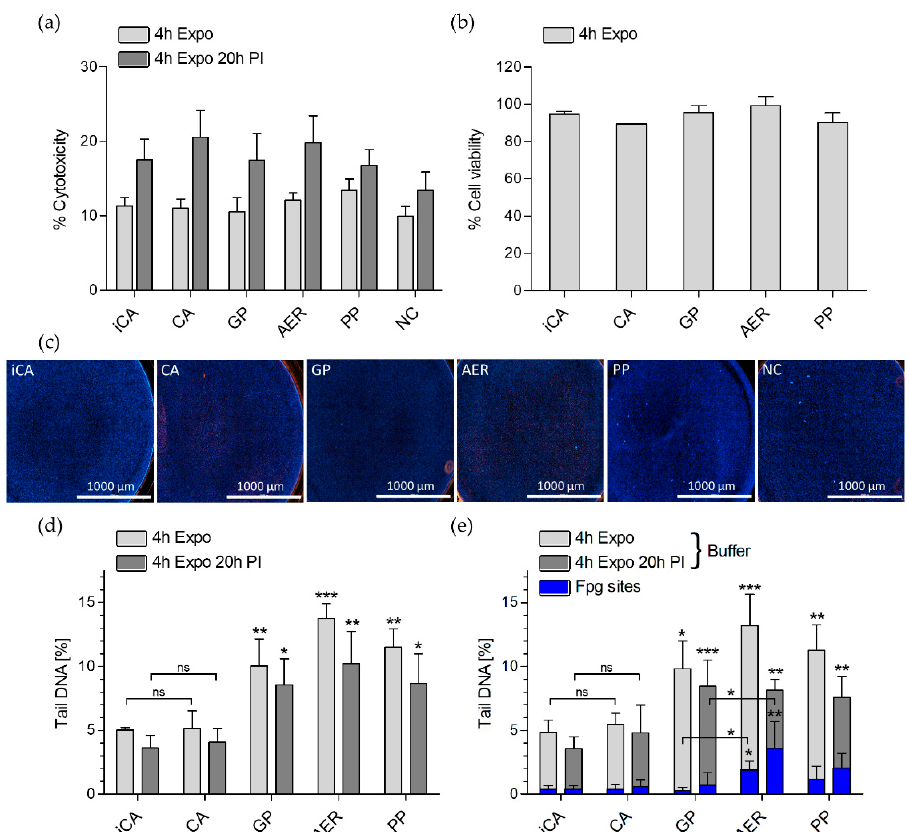
Figure 2. Toxicity assessment of DBP gas versus particle phase and total aerosol on human lung A549 cells exposed at ALI. A549 cells were exposed to DBP over 4 h with or without 20 h post incubation (4 h Expo or 4 h Expo 20 h PI). ( a ) % Cytotoxicity compared to the NC measured by LDH assay and normalized to the total LDH release (2% Triton X-100 positive control) ( n ≥ 6), ( b ) % Cell viability measured by resazurin assay and normalized to the NC ( n = 3), and ( c ) Live/dead cell imaging with 5 µ g/mL H 33342 to stain the nuclei (blue) and 2.5 µ g/mL propidium iodide (red) to selectively stain dead cells after 4h Expo to iCA, CA, or the different SVOC phases of DBP. ( d ) Genotoxicity assessed by comet assay with the alkaline version and ( e ) the enzyme version with Fpg and the respective Buffer controls (without Fpg) after the respective time points ( n ≥ 3). iCA = independent clean air, CA = clean air, GP = gas phase, AER = aerosol, PP = particle phase, NC = negative control. Data are shown as mean ± SD. Significances are shown in comparison to the iCA of the respective time point (Statistical analysis via Tukey One-way ANOVA, * p ≤ 0.05, ** p ≤ 0.01, *** p ≤